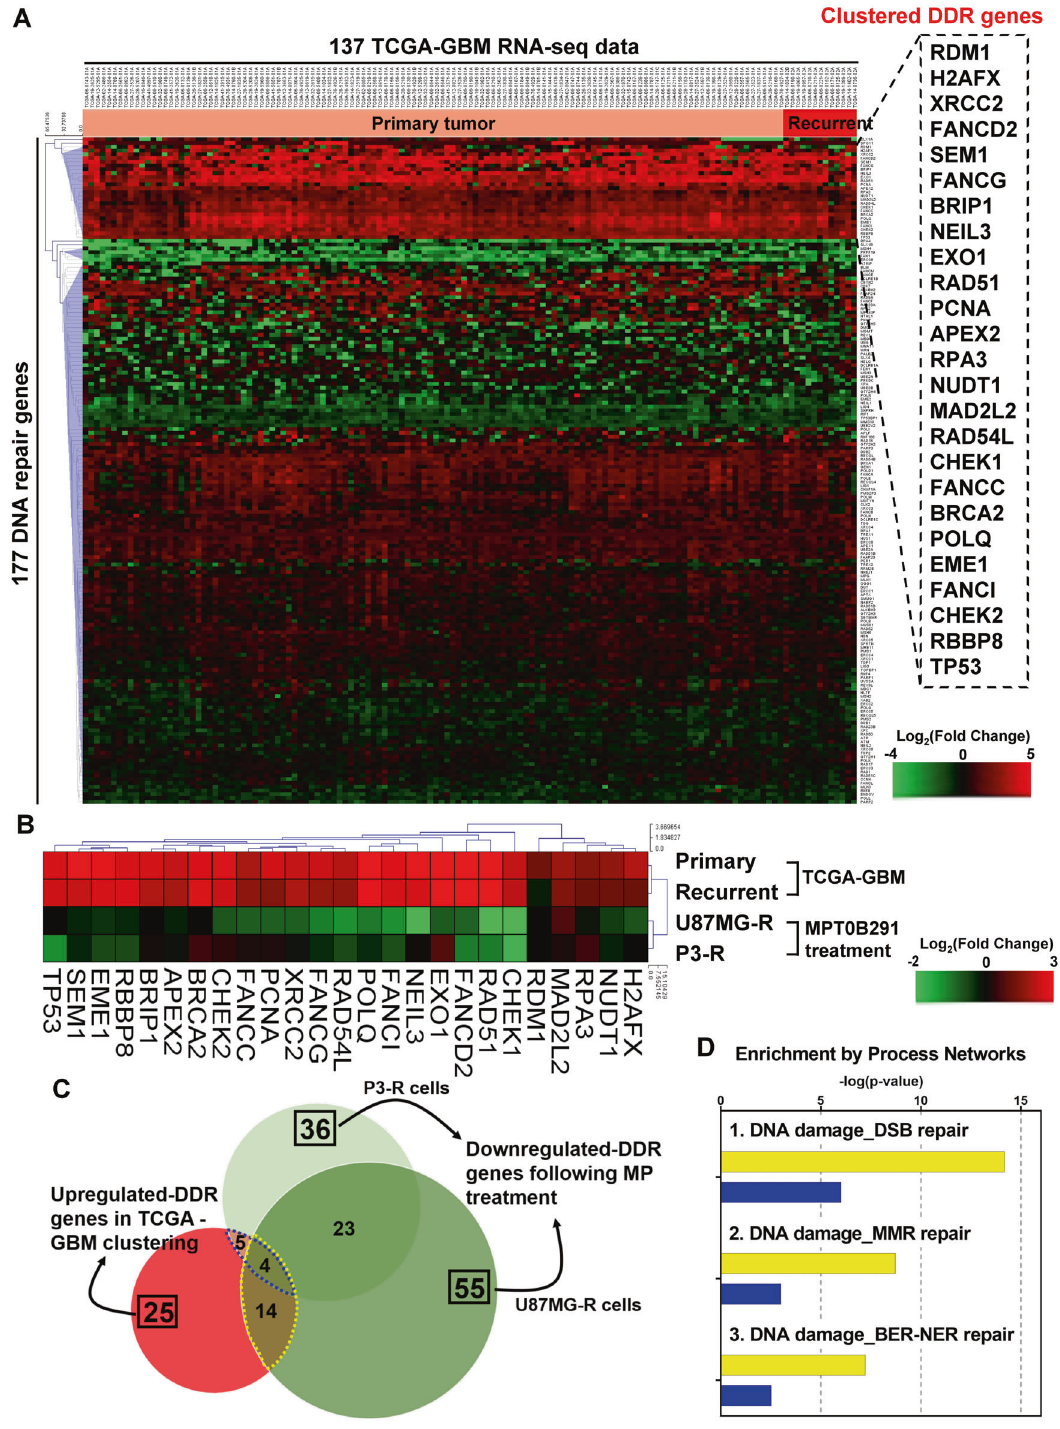
Fig. 1 MPT0B291 reverses abnormal clinical features of DDR genes in GBM. A Heatmap representation of the expression levels of 177 well- de fi ned DDR genes in 137 clinical primary or recurrent GBM samples from the TCGA database. Twenty- fi ve upregulated genes (the clustered DDR genes) compared to solid normal controls were clustered using the Euclidean distance method and shown in the dashed frame on the right panel. B Heatmap representation of fold changes of the clustered DDR genes identi fi ed by the above analysis in primary and recurrent tumors versus normal brain tissue and in MPT0B291-treated U87MG-R and P3-R cells versus DMSO-treated parental cells. C Venn diagram showing overlaps between the number of DDR genes that were upregulated (two-fold increase) in TCGA-GBM dataset or downregulated (1.5- fold decrease) after MPT0B291 treatment in U87MG-R and P3-R cells. D MetaCore analysis was conducted on the intersected genes between TCGA-GBM dataset and MPT0B291-treated U87MG-R/P3-R cells according to the above analysis to evaluate their functions. The yellow and blue bars show results of 14 and 5 co-regulated DDR genes, respectively. The number of involved genes is shown on the bars.